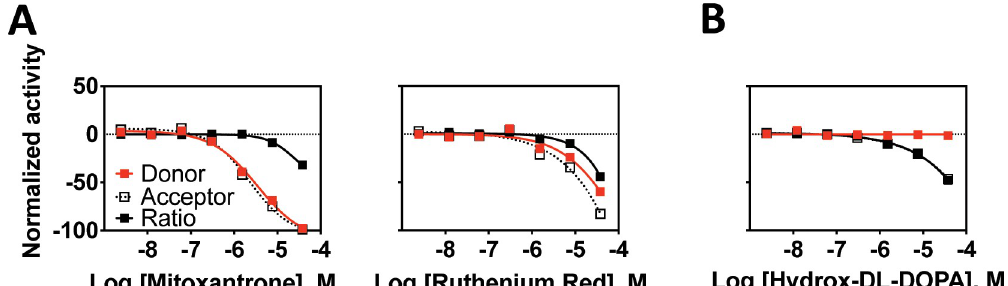
Fig 10. LOPAC active compounds from the LANCE TR-FRET assay. Normalized activity signal for the donor and acceptor channels and calculated ratio signal for each active compound reported for the 7-point concentration response generated using qHTS. Normalized activity was calculated with neutral control (+CD47 +SIRP α , no inhibitor) as 0% and low control (+CD47 -SIRP α , no inhibitor) as -100% activity. Assay activity with tested compounds was then compared and normalized within this range. (A) Compounds that interfered with donor fluorescence indicated by activity in the donor channel. (B) Reactive compound active in a variety of other unrelated screening assays (Pubchem).